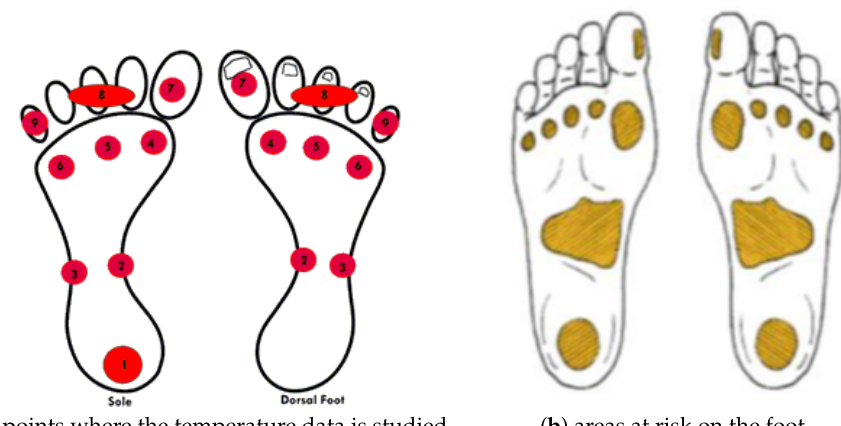
( b ) areas at risk on the foot Figure 5. ( a ) we show a scheme with the points where the temperature data is studied: the plant and dorsal areas correspond to the same position, except for the number one that is only in the sole: (1) heel, (2) medial midfoot, (3) lateral mid-foot, (4) first metatarsal head, (5) central metatarsal heads, (6) fifth metatarsal head, (7) first finger, (8) central fingers, and (9) fifth finger; ( b ) there is an illustration with areas at risk on the foot taken from